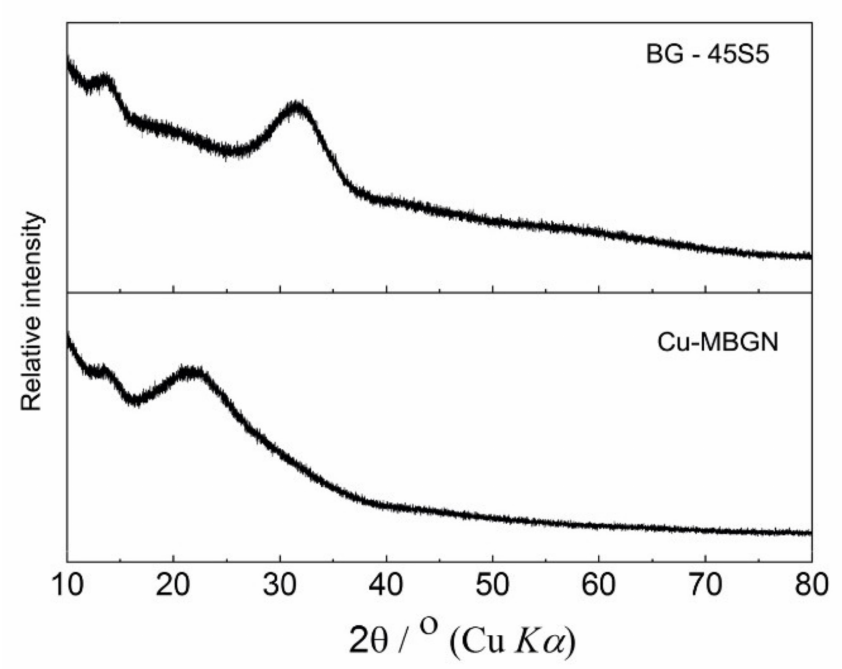
Figure 1. XRD spectra of conventional 45S5 bioactive glass (BG-45S5) and copper-doped mesoporous bioactive glass nanospheres